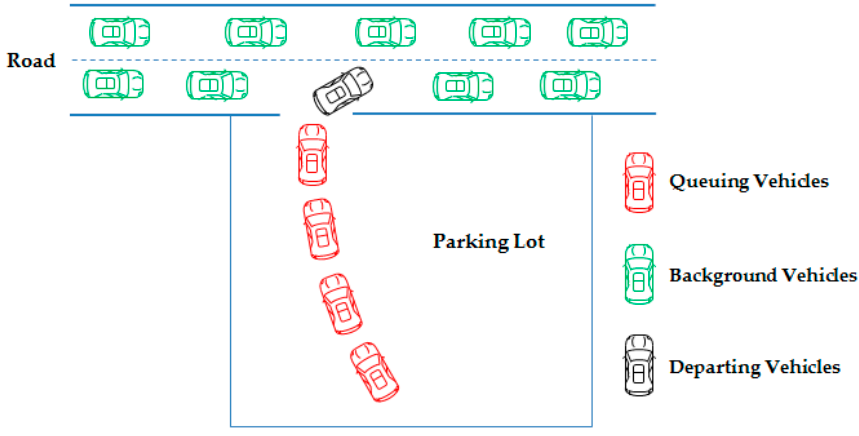
Figure 1. Vehicle evacuation process in a parking lot.